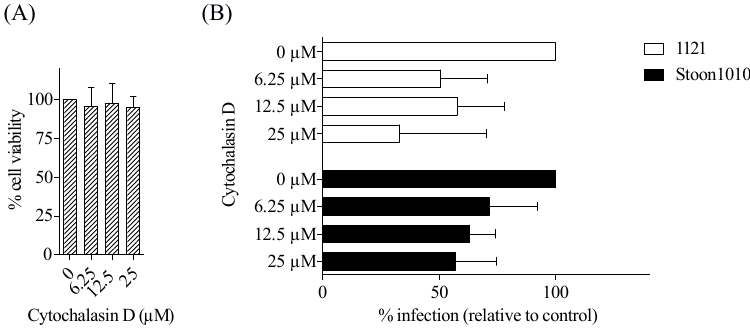
Figure 10. PCV2 entry into T-lymphoblasts requires actin. ( A ) Viability of cells treated with different concentrations of cytochalasin D, as measured by MTT assay. ( B ) Cells were pre-treated with cytochalasin D (0, 6.25, 12.5, 25 µM) prior to PCV2 infection. The percentage of PCV2-infected cells was quantified. The infection level in the treated group was expressed as the relative percentage to that of the control group (drug concentration = 0 µM). Data represent means ± SD of triplicate assays.